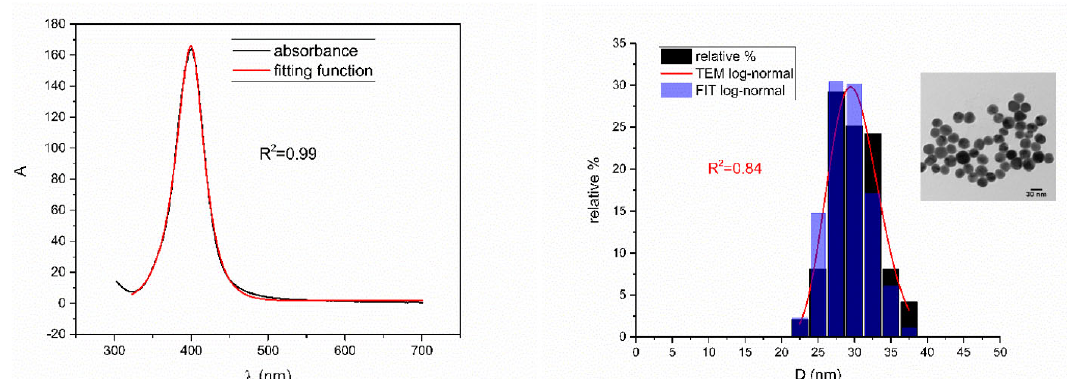
Figure 7. UV-Vis spectrum with fitting function ( left ) for sample BioP_4. Reported and reconstructed size distributions are shown on the ( right ). An additional TEM image is also shown.